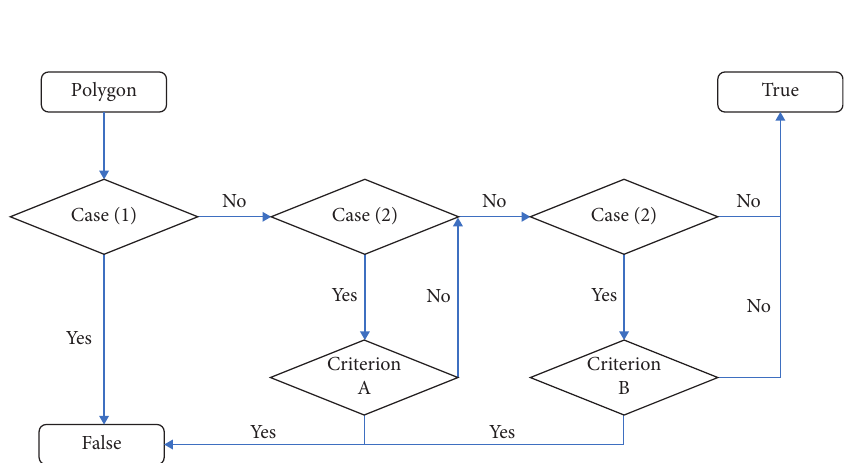
Figure 3: Flowchart of the judgment criterion.